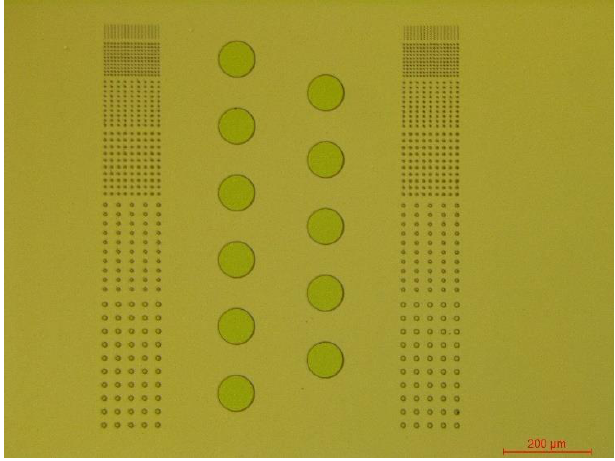
Figure 2. The pattern of sample cell.